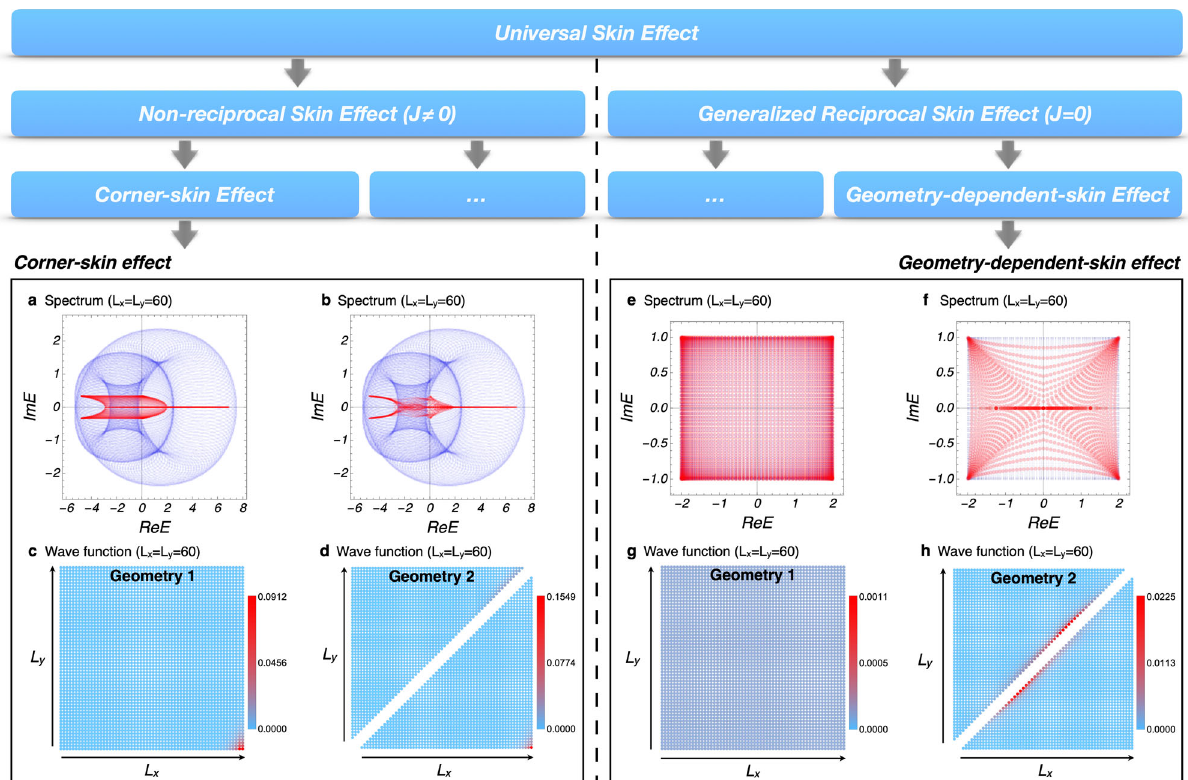
Fig. 3 The corner-skin effect and the geometry-dependent-skin effect. The universal skin effect can be further classi fi ed into two types by the current functional, that is, non-reciprocal skin effect ( ∃ α , n , J α [ n ] ≠ 0) and generalized reciprocal skin effect ( ∀ α , n , J α [ n ] = 0). CSE ( a ) – ( d ) and GDSE ( e )-( h ) are representatives of these two types of skin effects, respectively. In ( a , b , e , f ), the light blue regions represent the spectrum under periodic boundary, where 200*200 k -grid is used, and the red points represent the eigenvalues under different open-boundary geometries. The system size under square geometry in ( c , g ) is L x × L y = 60 × 60, and each triangle geometry in ( d , h ) has the same right-angled side length L x = L y = 60. The spatial distributions of eigenstates W ( x ) are plotted in ( c , d , g , h ) with the color bars. In the system with GDSE, the skin effect disappears under square geometry (geometry 1) in (g), and reappears under triangle geometry (geometry 2) in ( h